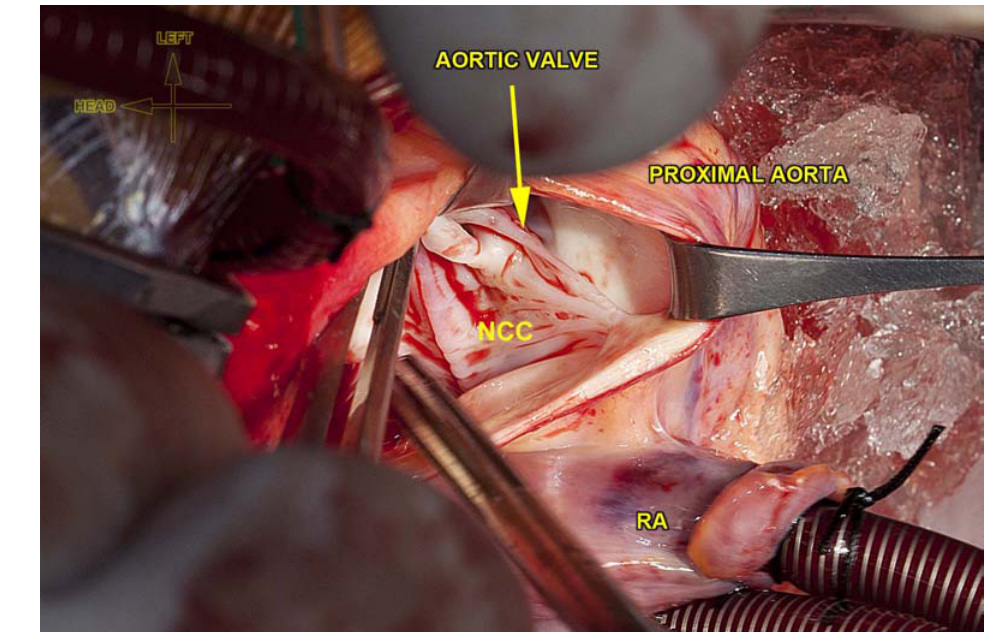
Figure 2. Operative photograph showing the redundant non coronary cusp (NCC). RA (right